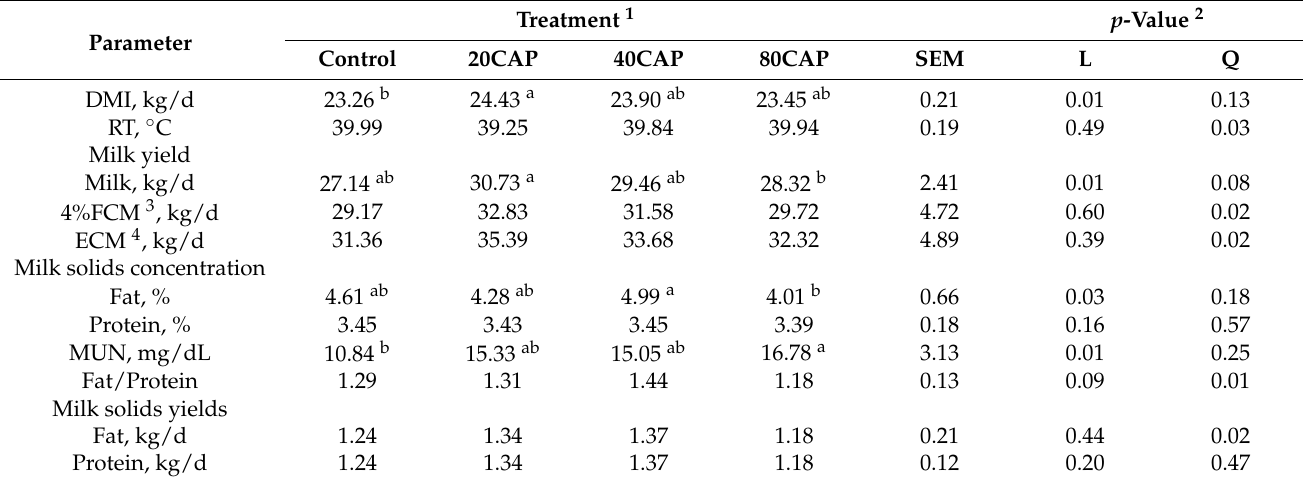
Table 3. Effects of Capsicum oleoresin (CAP) on production variables in heat-stressed dairy